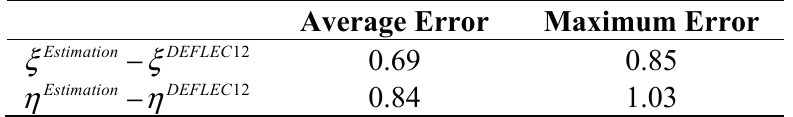
Table 5. The statistical analysis of ultimate DOV estimation result ( ″ ).